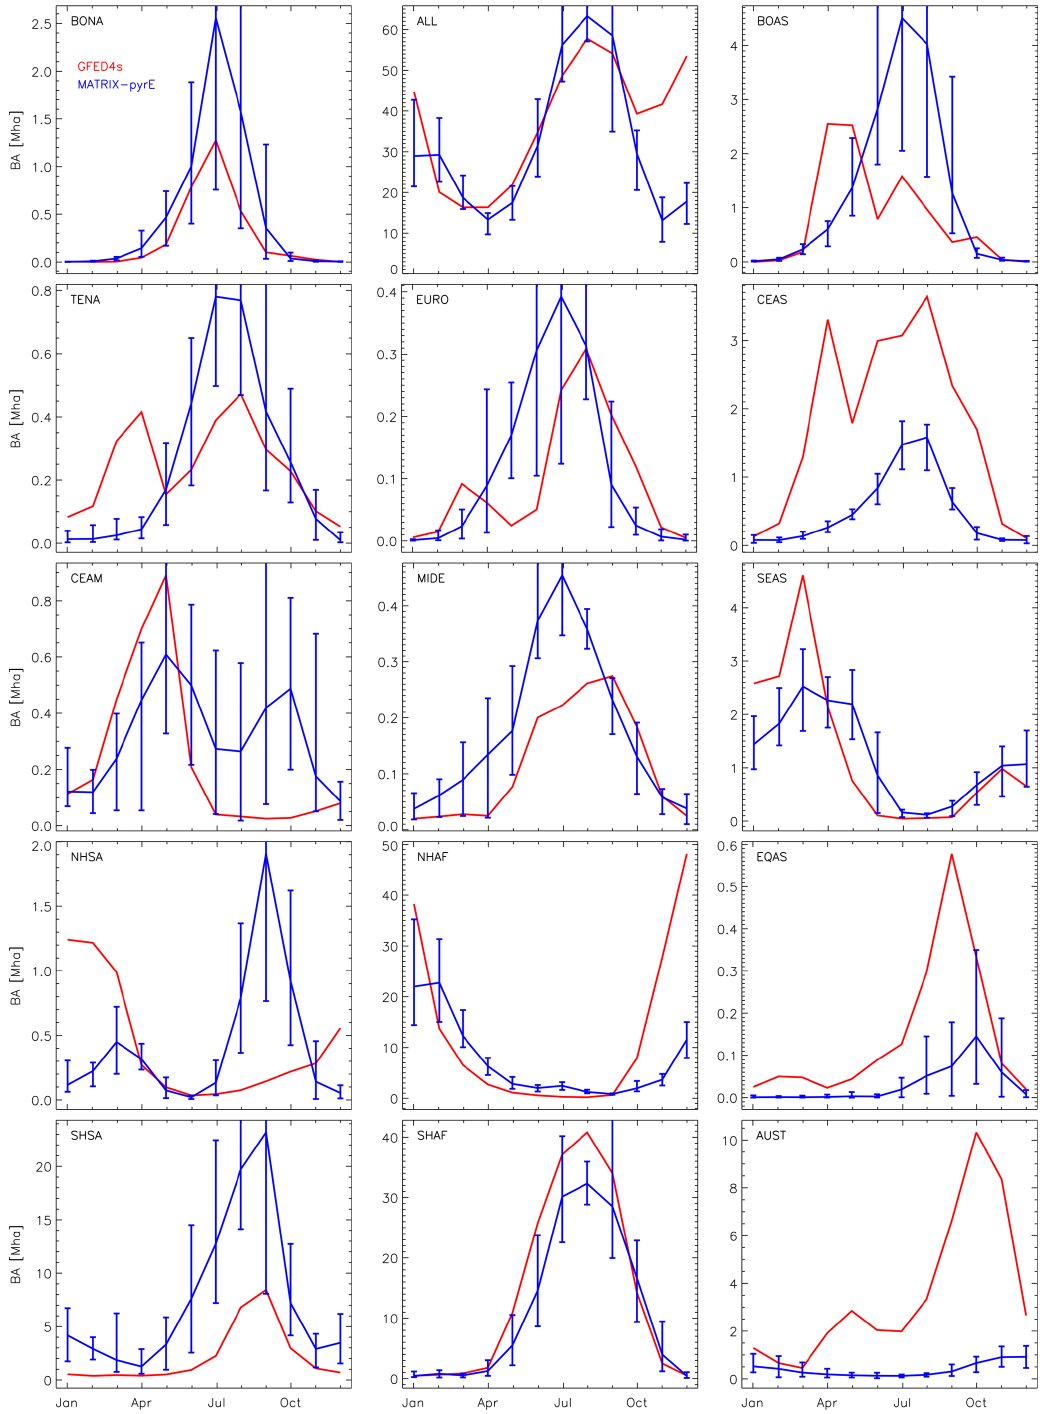
Figure A2. Seasonality of total burned area simulated (blue) and reported by GFED4s (red) in GFED regions. Error bars represent the 10-year range in the simulations. Note the different scales in each